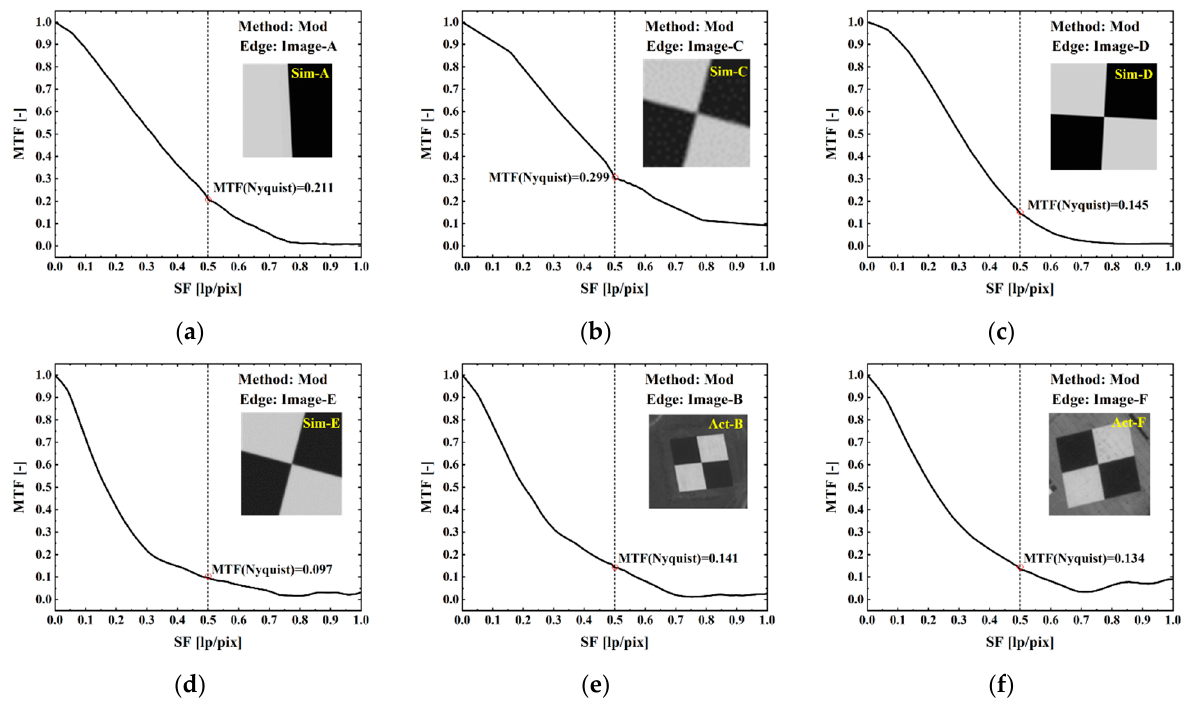
Figure 21. MTF measurements of Geo spatial quality reference dataset by Mod edge method: ( a ) Simulated edge image A, ( b ) Simulated edge image C, ( c ) Simulated edge image D, ( d ) Simulated edge image E, ( e ) Actual edge image B, ( f ) Actual edge image F. Table 3. MTF experiment result comparison between modified edge method and reference